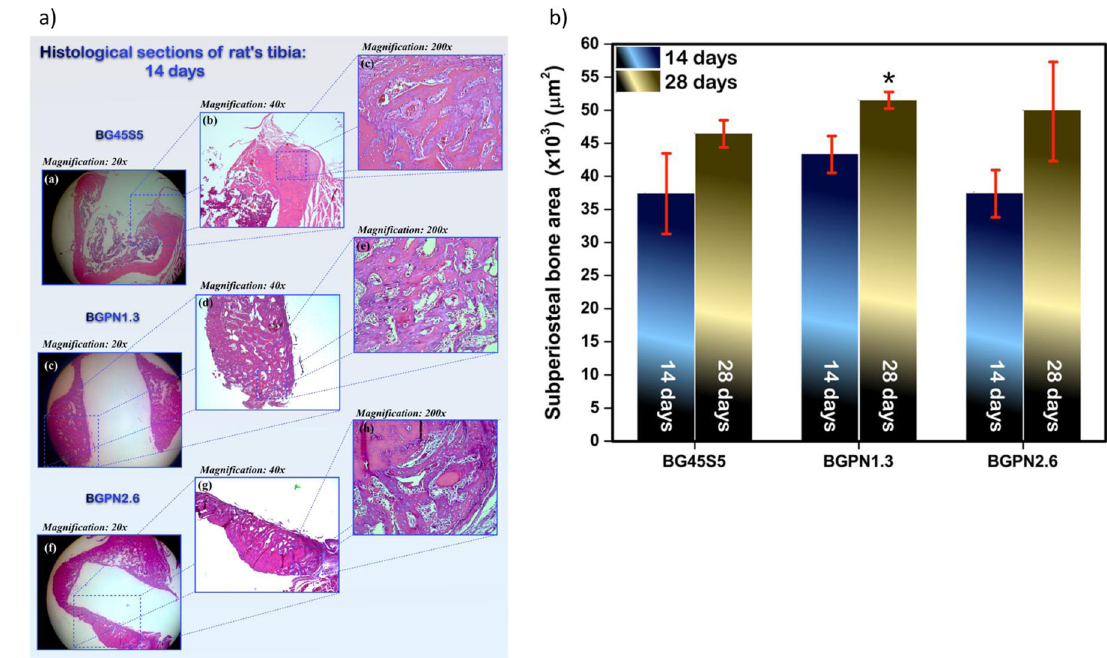
Fig. 4 In vivo implantation of Nb-containing 45S5 BG rods: a sub- periosteal new bone formation in rat tibia tissue defect after 28 days of implantation, hematoxylin & eosin staining, b growth area